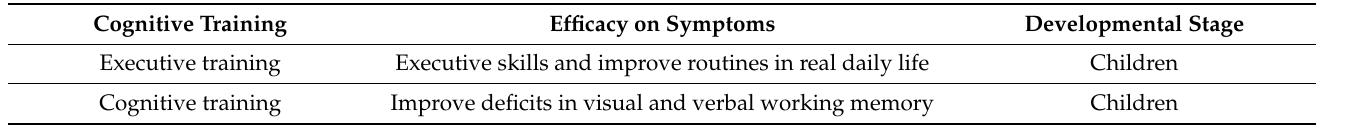
Table 4. Neuropsychological Treatments Evidence in ADHD.